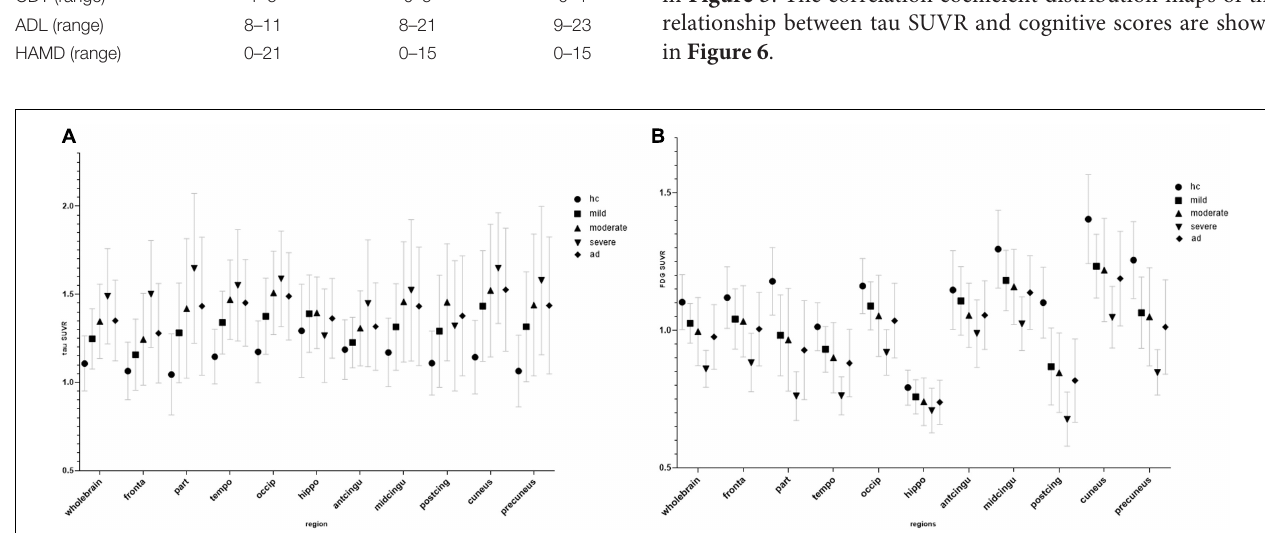
FIGURE 1 | Regional SUVR of FDG (A) and tau positron emission tomography (PET) (B) images in the control group and mini-mental state examination (MMSE) subgroup.